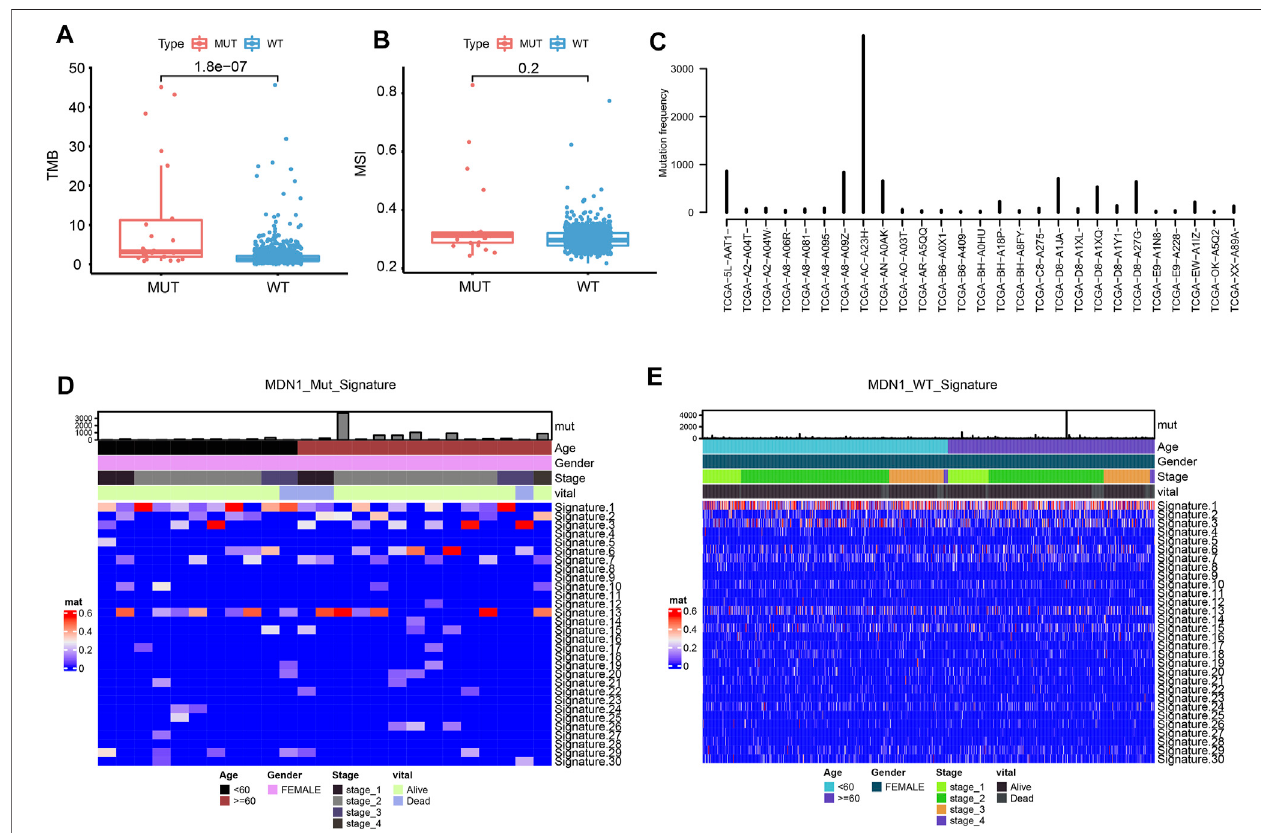
FIGURE3| BiologicalcharacterizationofMDN1genemutationinpatientswithBRCA. (A) TMBlevelsweresigni fi cantlyhigherinpatientswithMDN1mutationthan in MDN1 wild-type patients ( p < 0.001); (B) MSI values were not signi fi cantly different between the two groups ( p = 0.2); (C) Individual mutation frequencies in MDN1 mutated group; (D) COSMIC signature heatmap analysis of MDN1 mutated patients from TCGA-BRCA dataset; (E) COSMIC signature heatmap analysis of patients in the MDN1 WT group from TCGA-BRCA